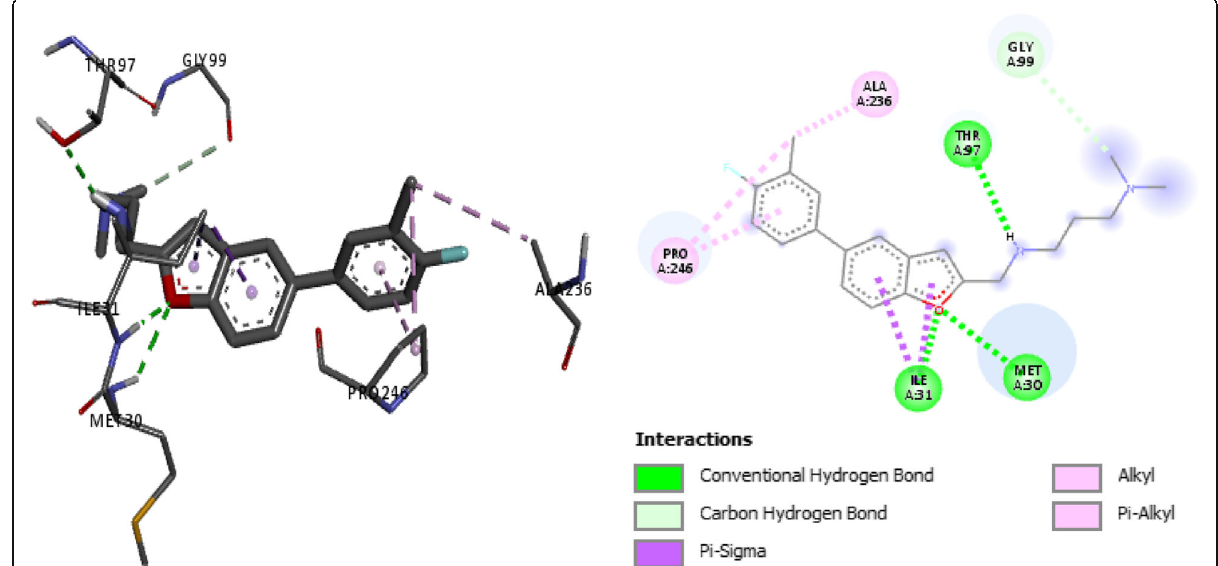
Fig. 4 3D and 2D structures of 22- pf LDH